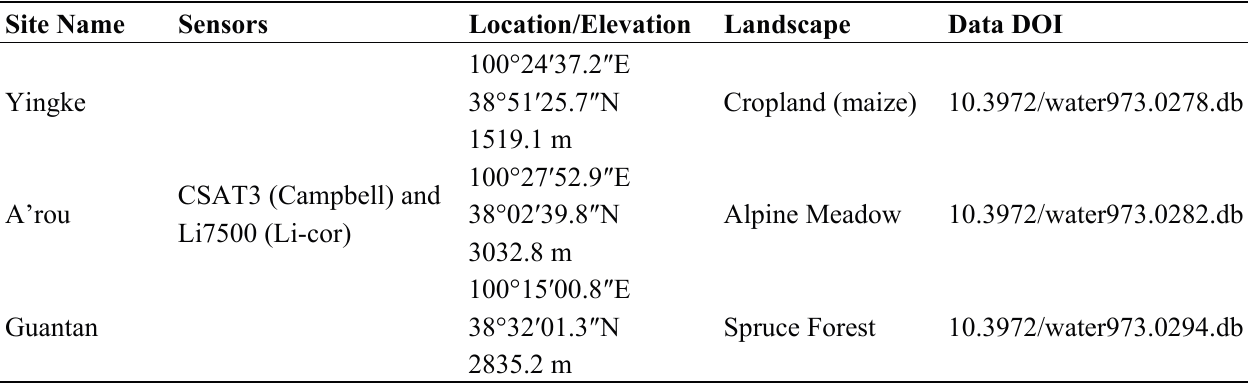
Table 1. Eddy covariance flux sites of the Watershed Allied Telemetry Experimental Research (WATER) used for ETa evaluation at local